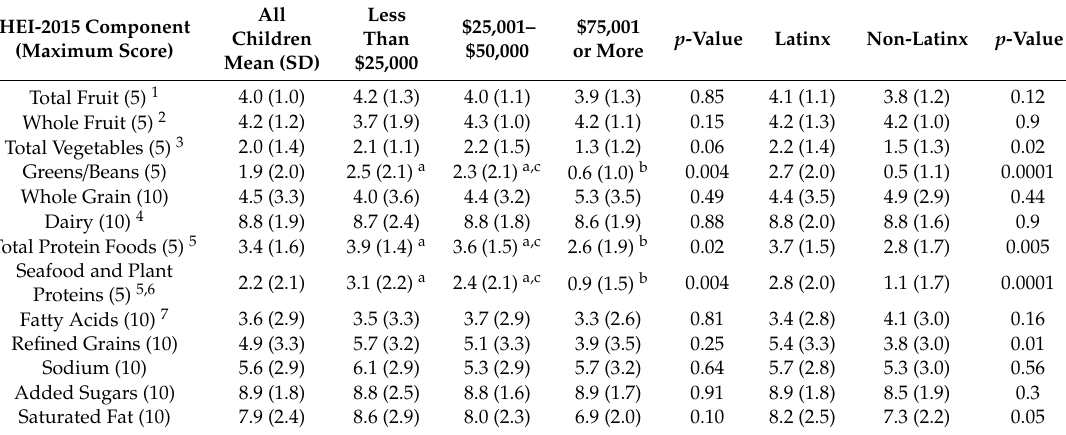
Table 3. Mean Healthy Eating Index (HEI-2015) total and component scores of foods consumed by children of ages 2 to 5 years attending family childcare homes ( n = 120) in Rhode Island and Massachusetts by income and